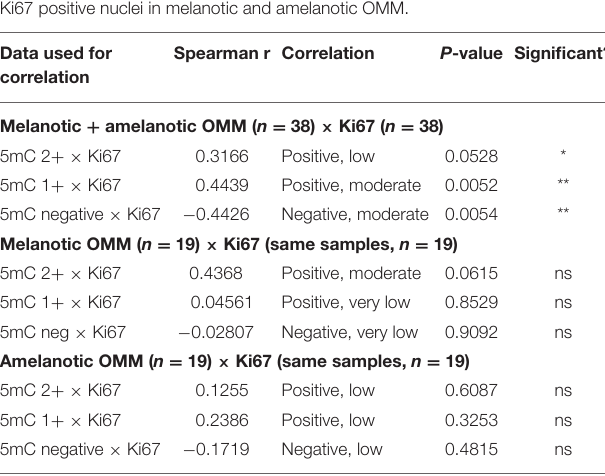
chromatograms that refer to dC and 5mC. By analyzing the chromatograms, peripheral blood leukocytes from melanotic OMM and amelanotic OMM patients and controls were found